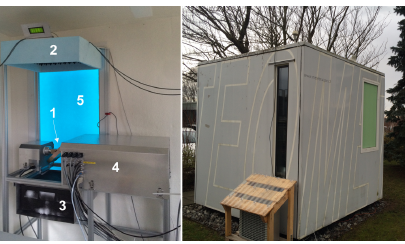
Figure 1. The TEMPERA instrument at the MeteoSwiss Station in Payerne, Switzerland.